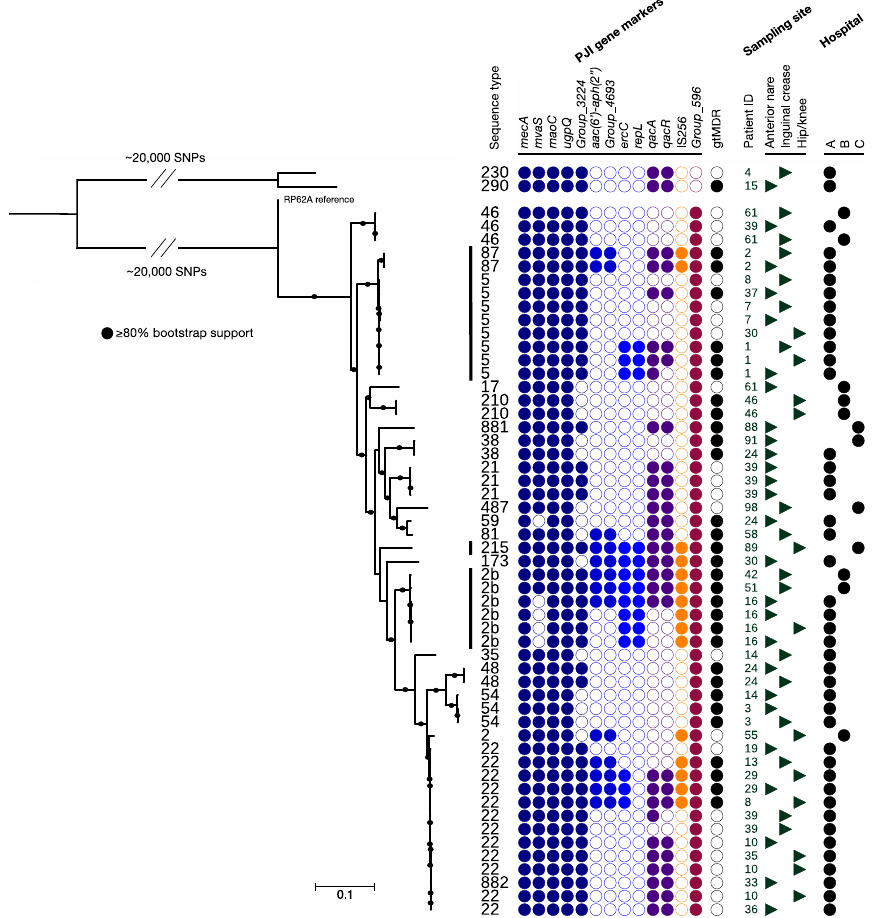
Figure 2. Phylogenetic relatedness of 55 mecA -positive S. epidermidis isolates retrieved from sampling of 66 patients prior to hospitalization for prosthetic joint surgery: the lineages previously associated with PJIs in Sweden (ST5, ST215, and ST2b) are indicated with a solid bar. Columns from left to right: sequence type (ST), genes previously associated with PJI origin (genes associated with SCC mec [dark blue], aminoglycoside resistance [medium blue], macrolide-lincosamide resistance [light blue], chlorhexidine tolerance [purple], IS 256 [orange], and genes coding for proteins of unknown function [dark red]), genotypic multidrug-resistant (black), patient running number, sample origin (body area), and hospital. The mid-point rooted phylogeny was based on 66,152 SNPs, and the scale bar indicates substitutions per site.